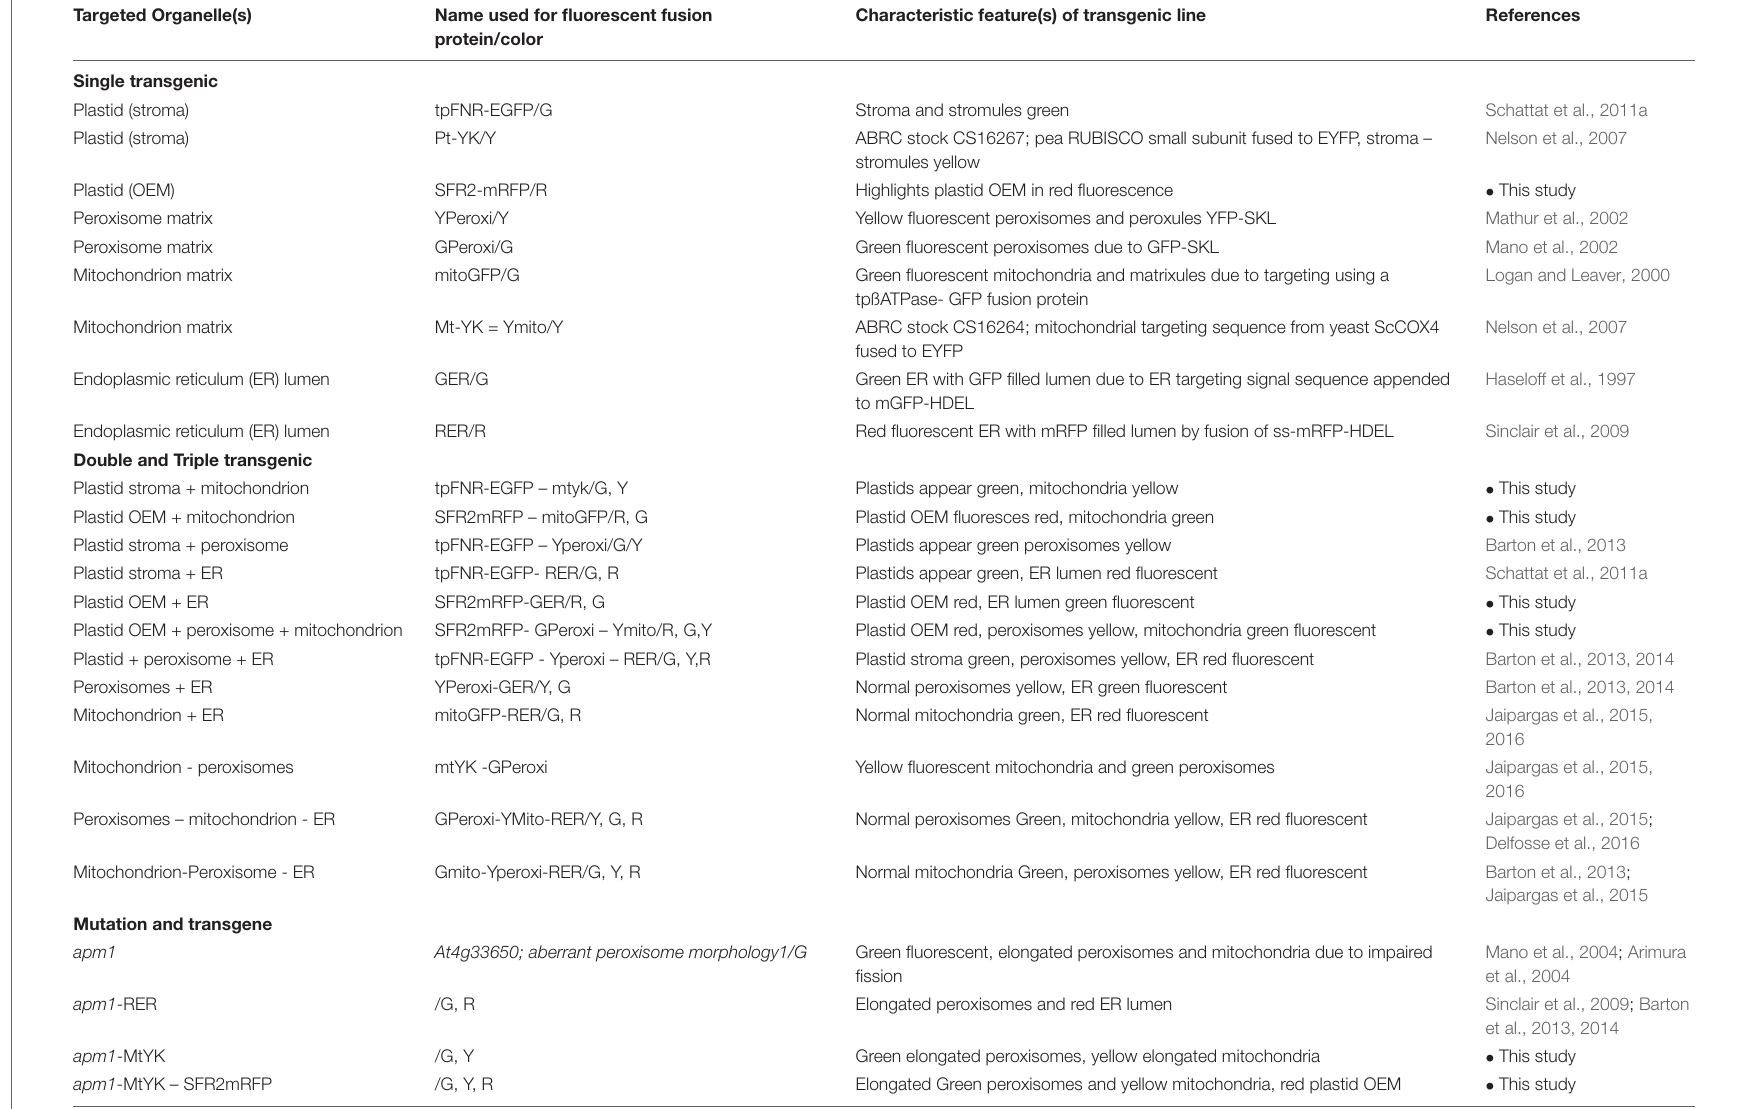
TABLE 1 | Transgenic Arabidopsis plants and mutants used in the